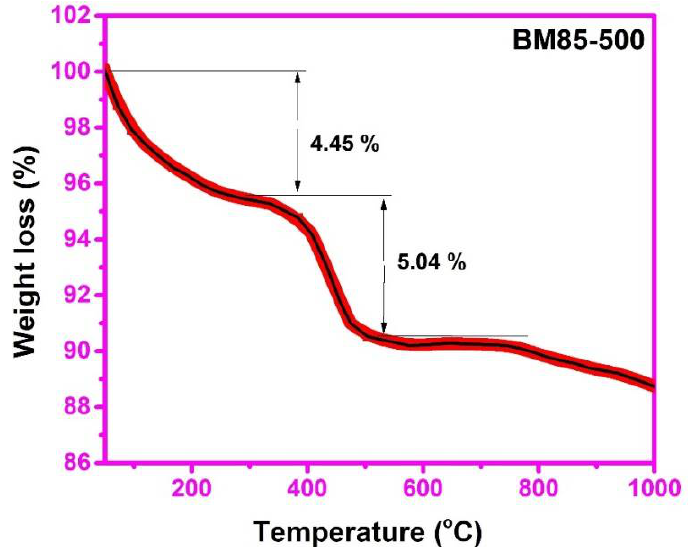
Figure 6. Thermo-gravimetric analysis of oleic acid-coated BM85-500 NPs.